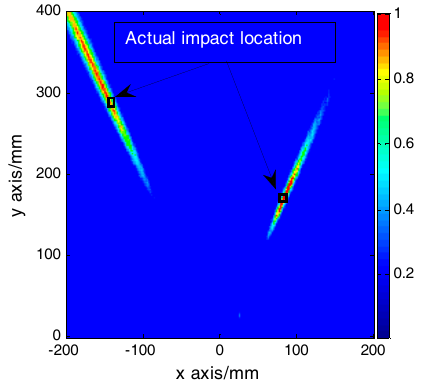
Figure 12. The localization spatial spectrum of ( − 149,289) and (89,172). Table 1. GDE coefficients.